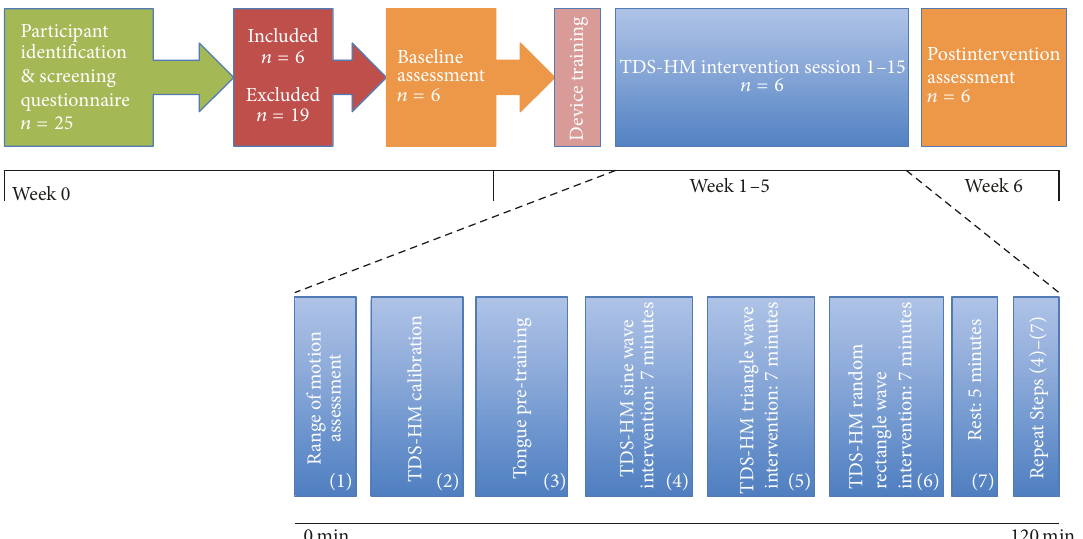
Figure 4: Participant flow through the study. Participant identification based on inclusion and exclusion criteria, followed by phone screening by research clinician. Baseline assessment and device training were completed upon first visit to the research setting. During each of the 15 training sessions, participants completed three sets, consisting of approximately six to eleven trials of sine, triangle, and random rectangle waveforms (40 seconds), in order, lasting four–seven minutes each. A short rest period of up to five minutes was allowed between each set to prevent muscle